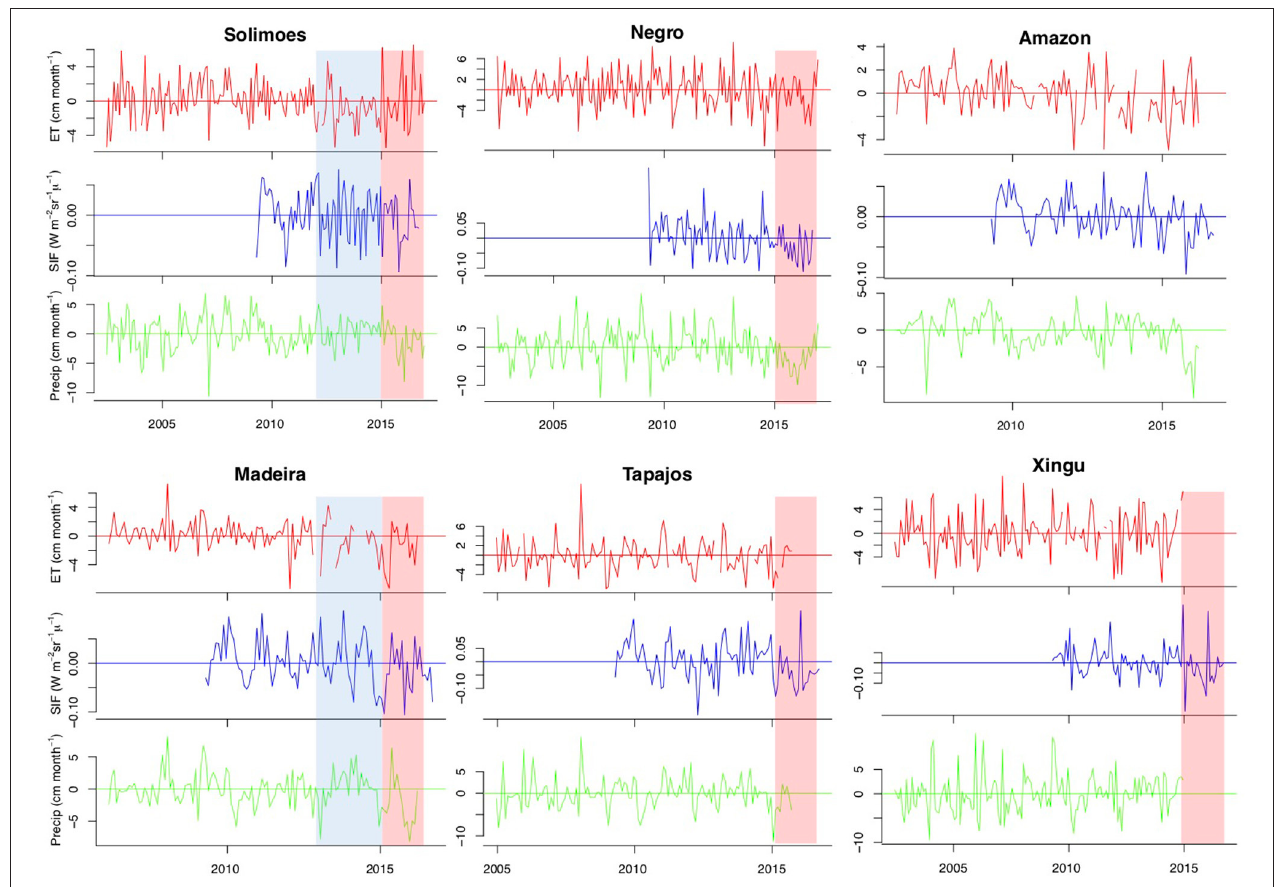
FIGURE 5 | Evapotranspiration, precipitation and solar induced fluorescence anomalies for all catchments in Figure 1 .